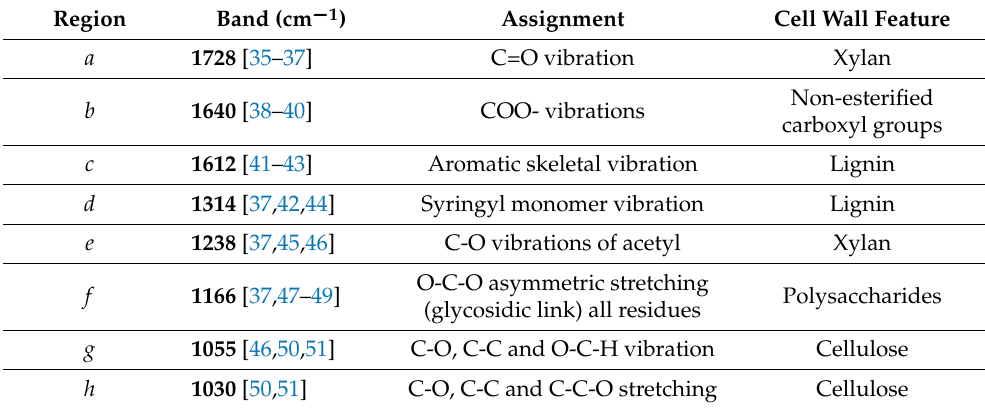
Table 1. Assignment of relevant FTIR-ATR absorption bands characteristic of cell wall biomass from Acacia